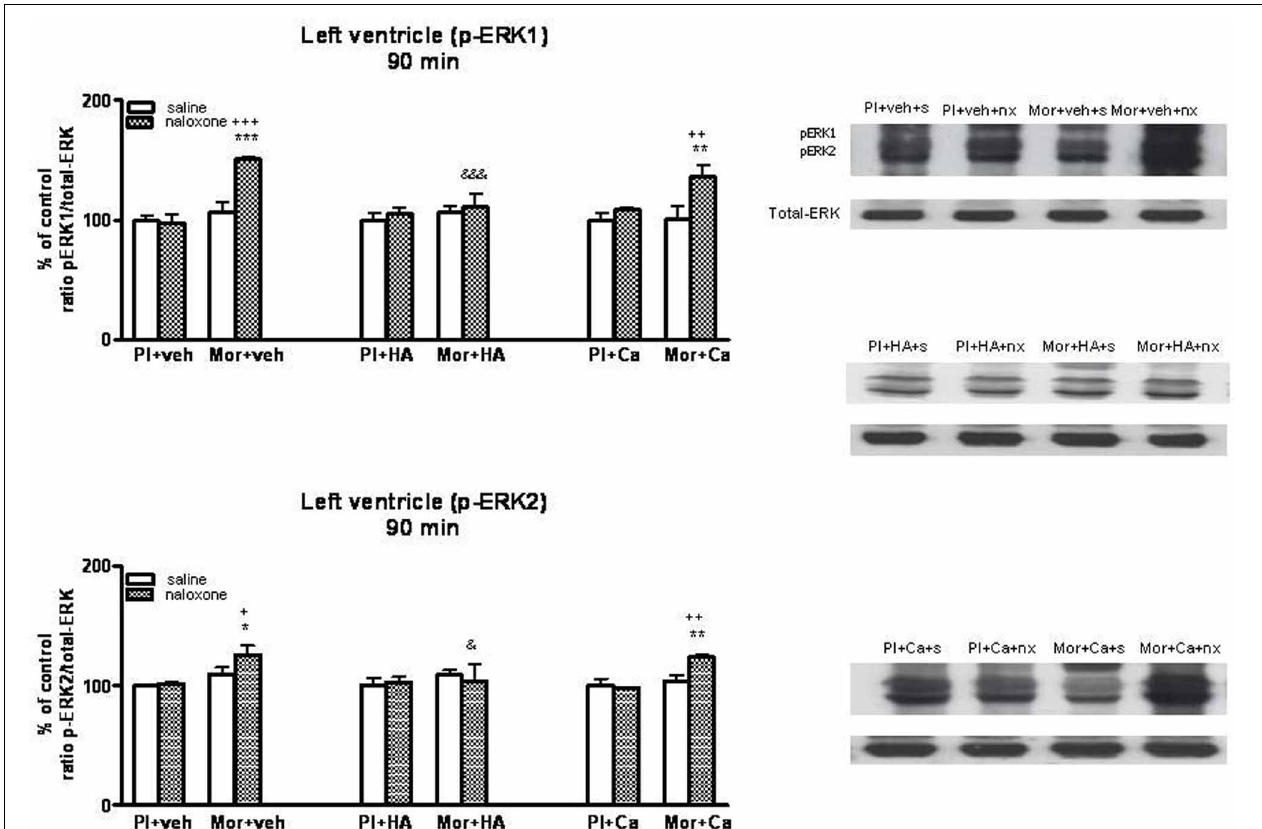
FIGURE 6 | Western blotting analysis of phospho (p)-ERK1 and phospho (p)-ERK2 immunoreactivity levels in the left ventricle 90min after saline (s) or naloxone (nx) administration to placebo (Pl)- or morphine (Mor)-treated rats receiving vehicle (veh), HA1004 (HA) or calphostin (Ca). The immunoreactivity corresponding to ERK1 or ERK2 is expressed as a percentage respect to the control group (Pl + veh + saline; defined as 100% value). Data are the mean ± s.e.m.